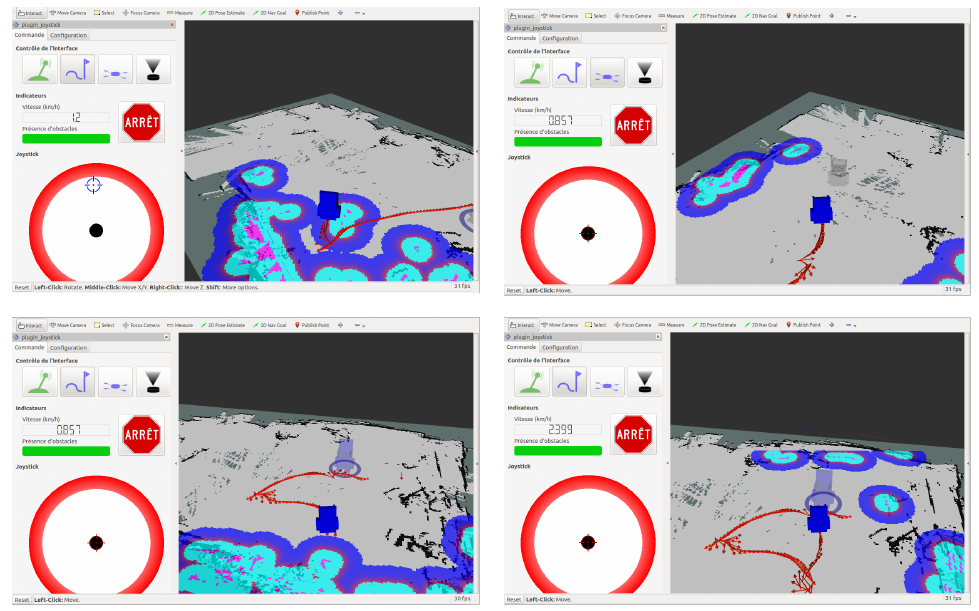
Figure 2. Graphical interface representing ( upper left ) the virtual joystick, ( upper right ) the IPW- shape-joystick and ( lower right and lower left ) the autonomous